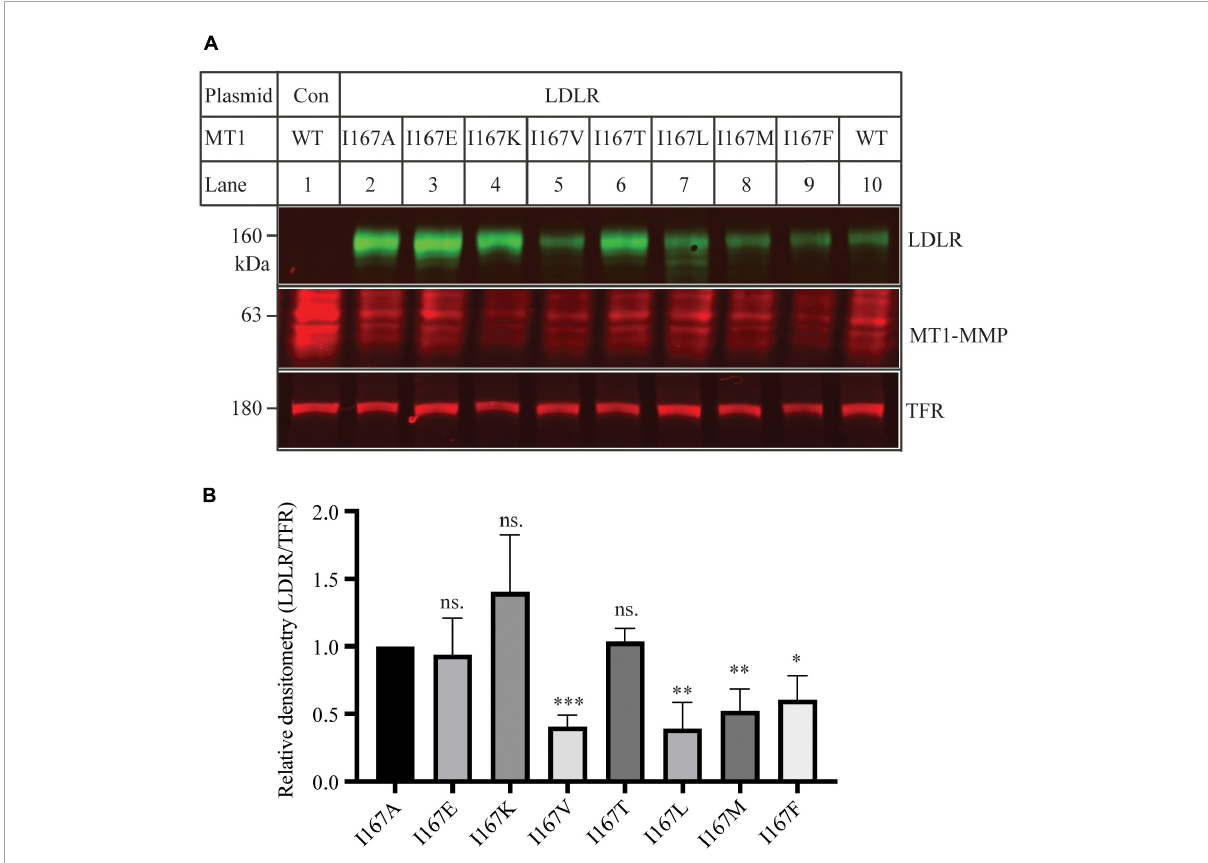
FIGURE6 Mutational analysis of I167 (A ) Immunoblotting and (B) quantification. Plasmid DNA containing wild-type LDLR was co-transfected with an equal amount of the wild-type or mutant MT1-MMP into HEK293 cells using Lipofectamine 3000. 48 h later, whole cell lysate was isolated and applied to immunoblotting with antibodies as described in the legend to Figure 5 . TFR, transferrin receptor. Representative images were shown (A) . Densitometry was determined by a Li-Cor Odyssey Infrared Imaging System. Relative densitometry was defined as the ratio of the densitometry of LDLR to that of TFR at the same condition (B) . Values were mean ± S.D. of ≥ 3 experiments. The significant difference between two groups (mutations vs. I167A) were determined via Student’s t -test. ns (no significance), p > 0.05, * p < 0.05, ** p < 0.01, *** p < 0.001.